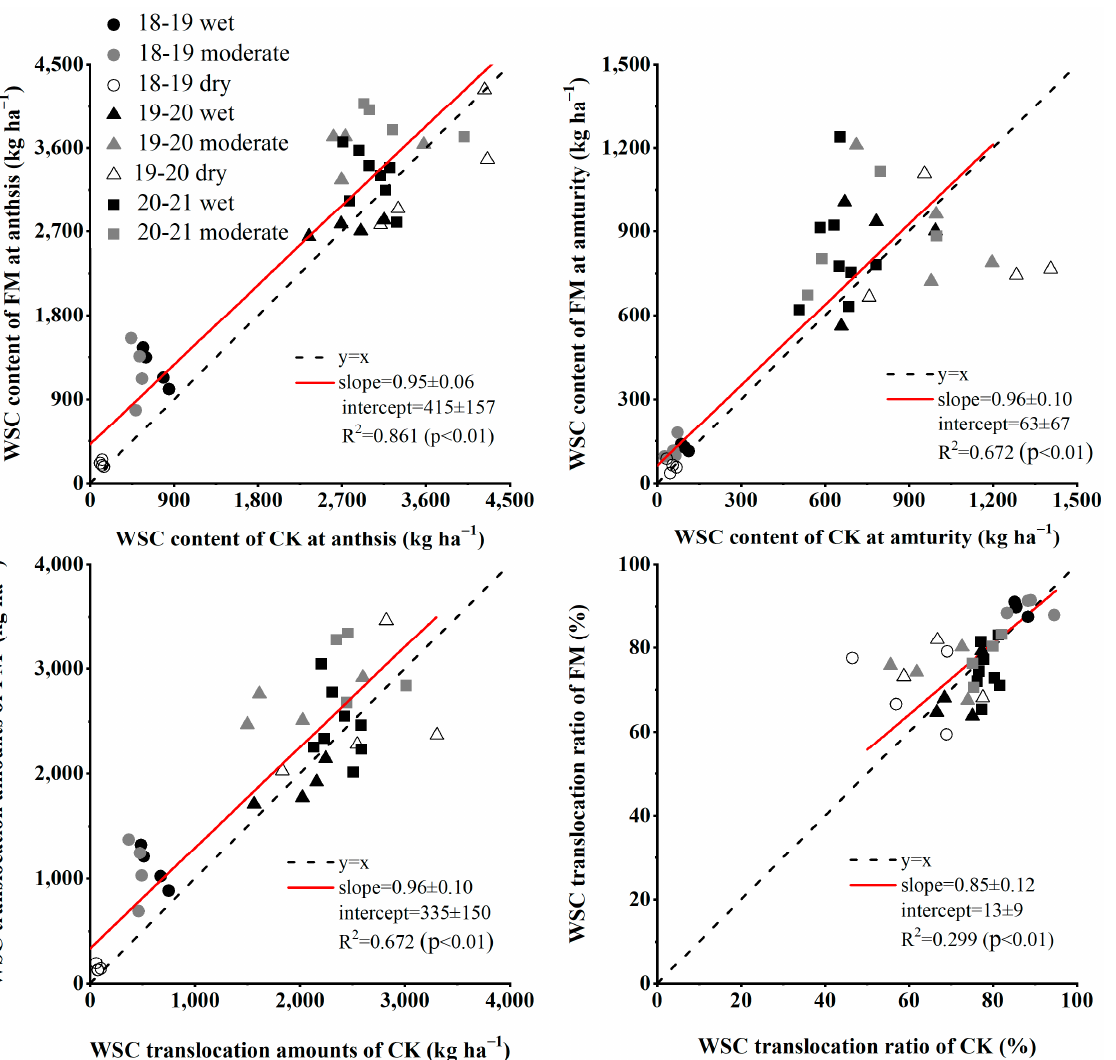
Figure 3. Comparison of water-soluble carbohydrates (WSC) between plastic film mulching (FM) and bare ground control (CK) wheat crops. WSC content at anthesis and maturity, apparent translocation amount, and ratio. Data including all treatments and seasons. Red solid line and equation is Model